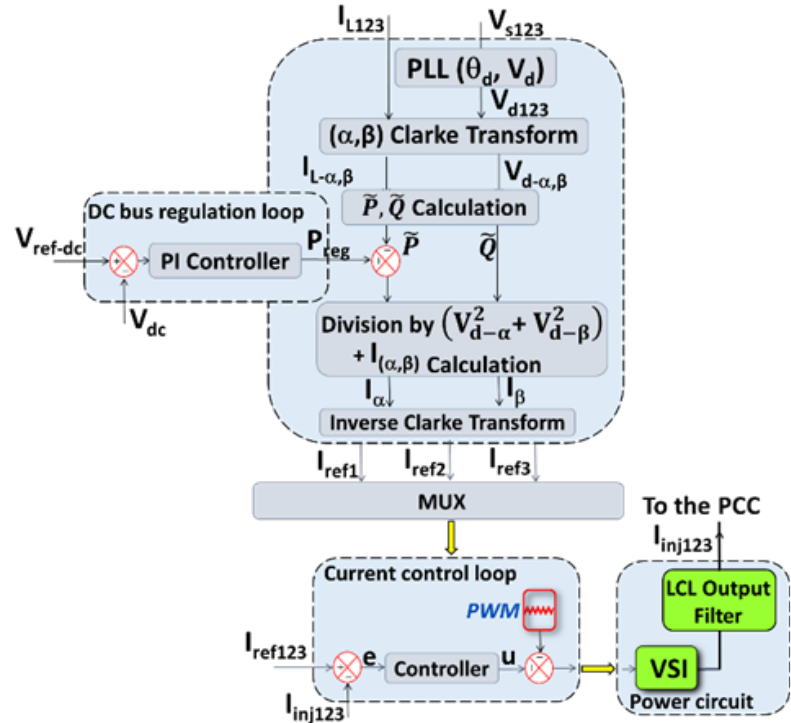
Figure 3. Advanced PLL-based generalized instantaneous power algorithm.